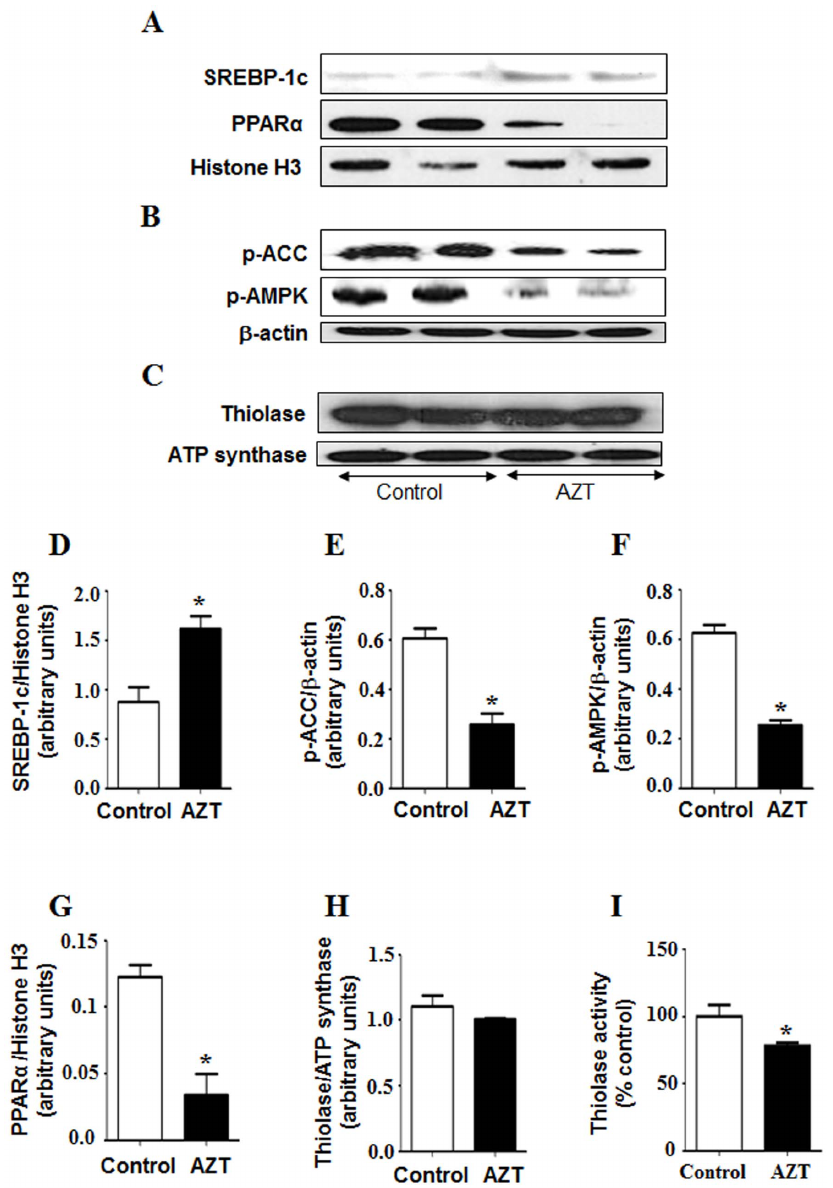
Figure 6. AZT-induced alterations of key proteins involved in fat metabolism. Equal amounts of nuclear, total liver homogenates and mitochondria from different groups were used to measure the levels of (A) n-SREBP-1, PPAR a and Histone H3 (as loading control for nuclear proteins) (B) p-ACC, p-AMPK and b -actin (as a loading control for total liver homogenates), and (C) thiolase and ATP synthase (as a loading control for mitochondrial proteins), respectively. (D–H) The density of each protein was normalized to that of the indicated loading control, respectively. (I) Thiolase activity was measured as described in the Materials and Methods. *Significantly different from the control group. Data indicate mean 6 SE, p , 0.05. All experiments have been conducted three